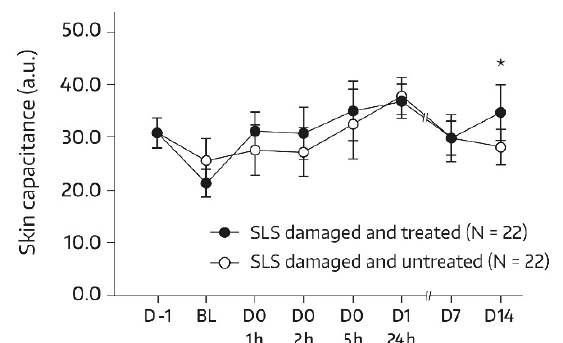
Figure 2. Results from skin capacitance measurements (forearm) in untreated SLS-damaged skin and SLS-damaged skin undergoing a single application of the face wash gel (first 24 h) followed by twice-daily applications for 13 days. The values were determined using corneometry and are presented as mean ± SD. The SLS challenge started on day -1 and stopped 24 h later (30 min before the BL assessment). BL—baseline skin capacitance value before the first product application; D—day; h—hour; SLS—sodium lauryl sulfate. * p = 0.039 if compared to untreated control, as measured using a paired t -test.